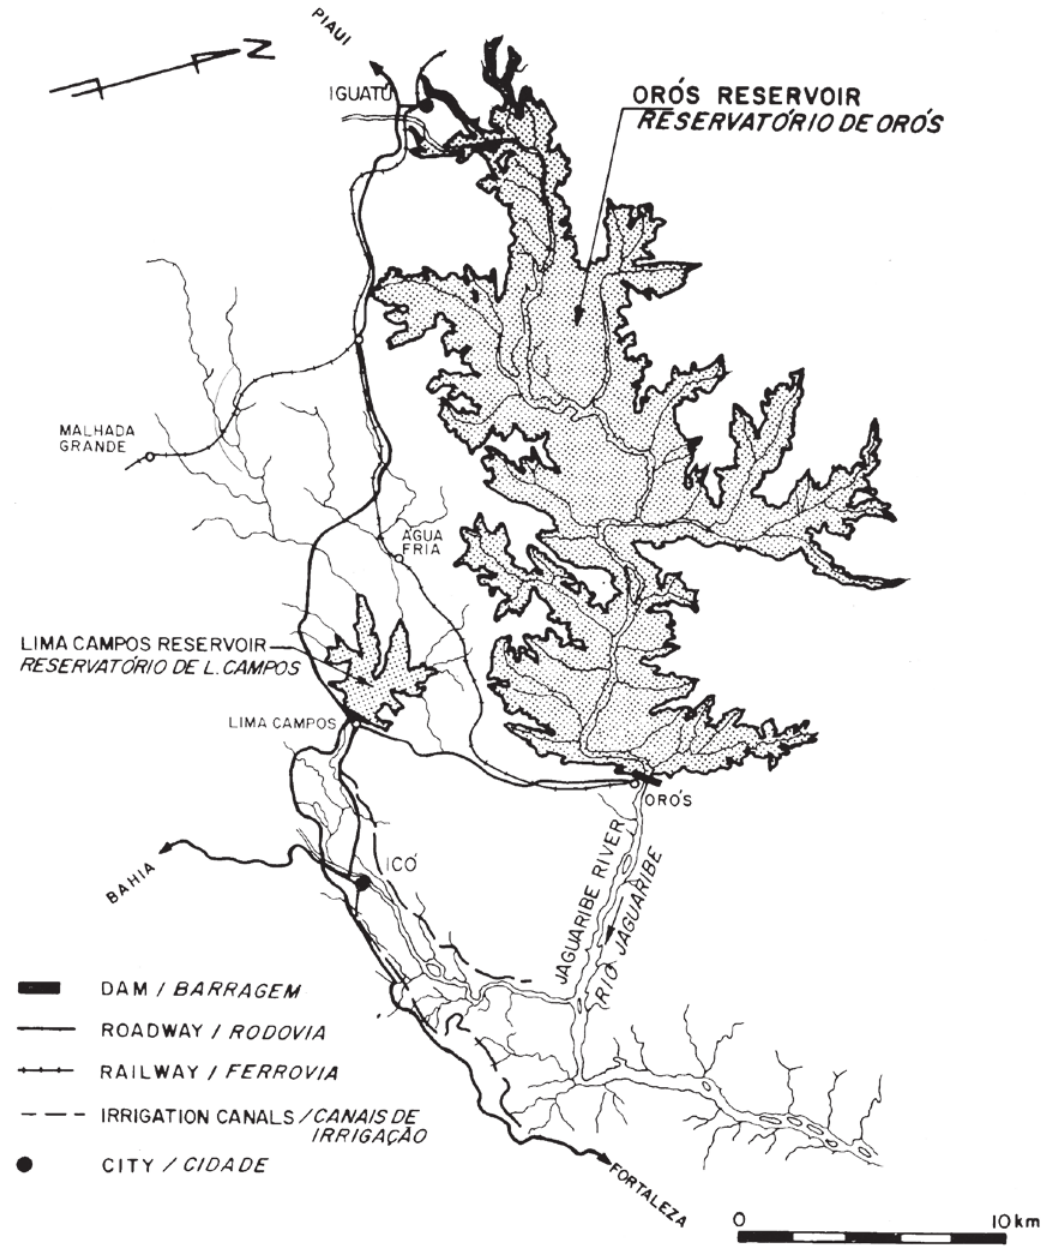
Figure 1 - Orós reservoir (Araújo